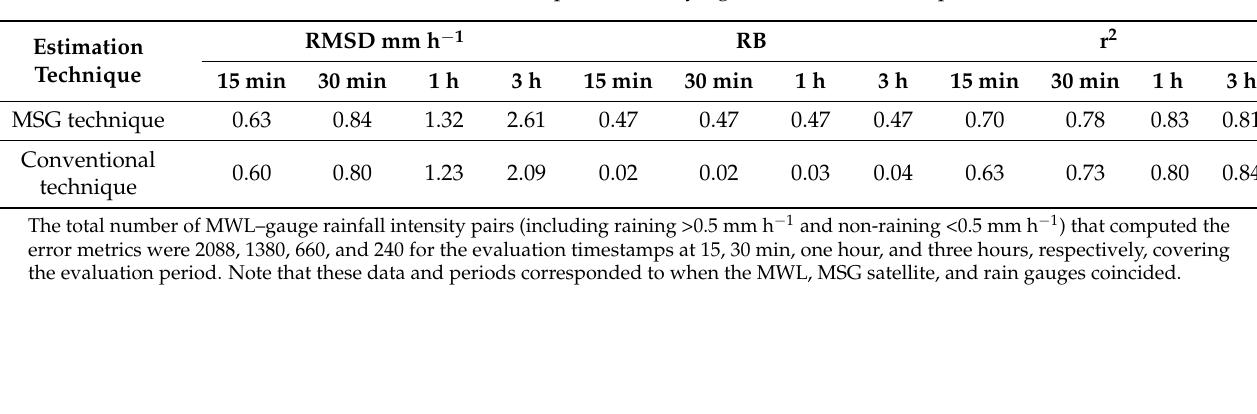
Table 2. Error metrics computed for varying evaluation